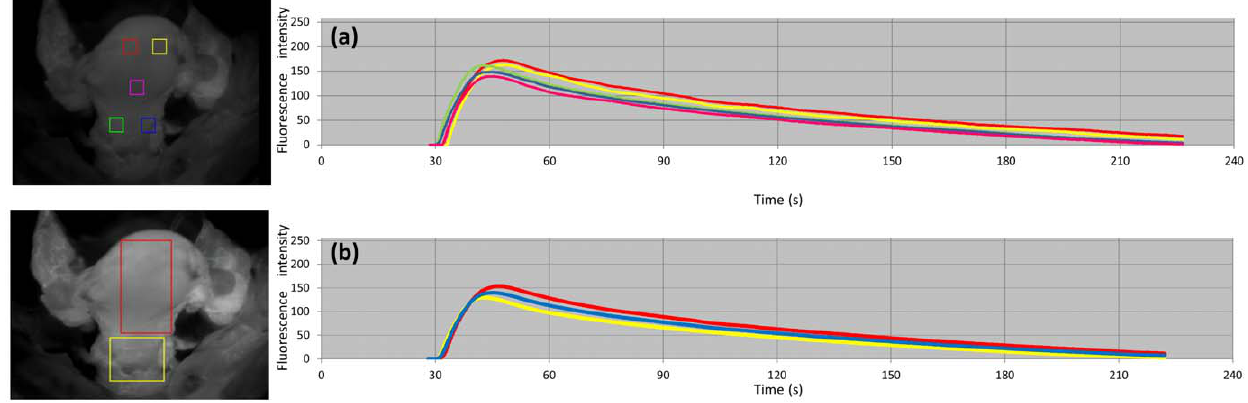
Figure 2. Time-intensity curves prepared by ROI software to show temporal changes in ICG fluorescence intensity (Pattern A). (a) Temporal changes in intensity in 5 specified regions (red: right uterine corpus, yellow: left uterine corpus, green: right uterine cervix, blue: left uterine cervix, pink: uterine isthmus) (b) Temporal changes in average intensity in the uterine corpus (red), uterine cervix (yellow) regions, and the whole uterine region including the corpus and cervix regions (blue).